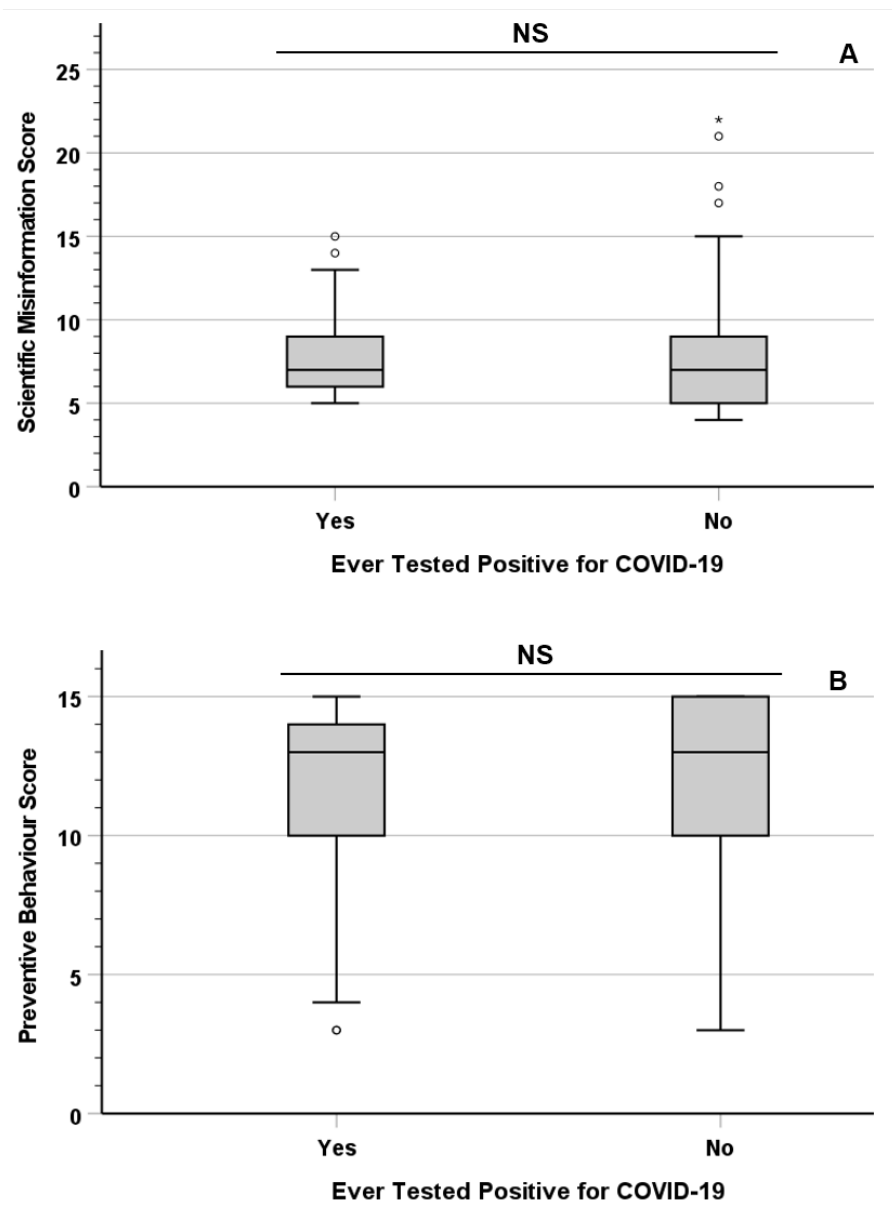
Figure 3. Scientific Misinformation Score ( A ) and Preventive Behaviour Score ( B ) for participants who tested positive for COVID-19 at least once and those who have not. Circles ( ◦ ) indicate mild outliers, asterisks (*) indicate extreme outliers.